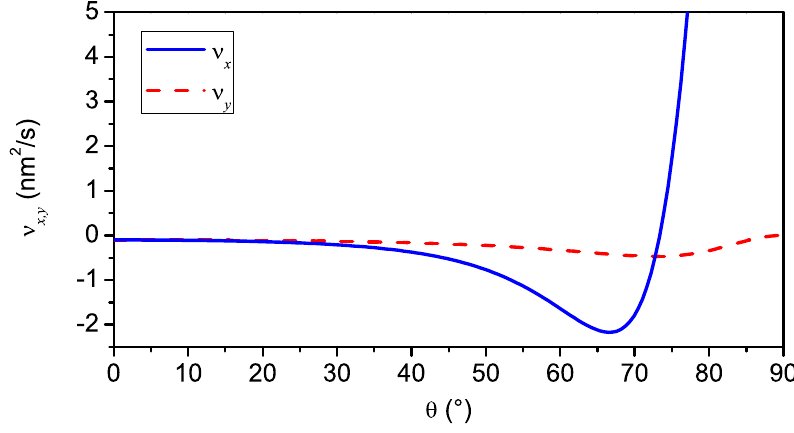
Figure 3. ν versus angle of incidence θ , calculated for 500 eV Ar + irradiation of Si x,y